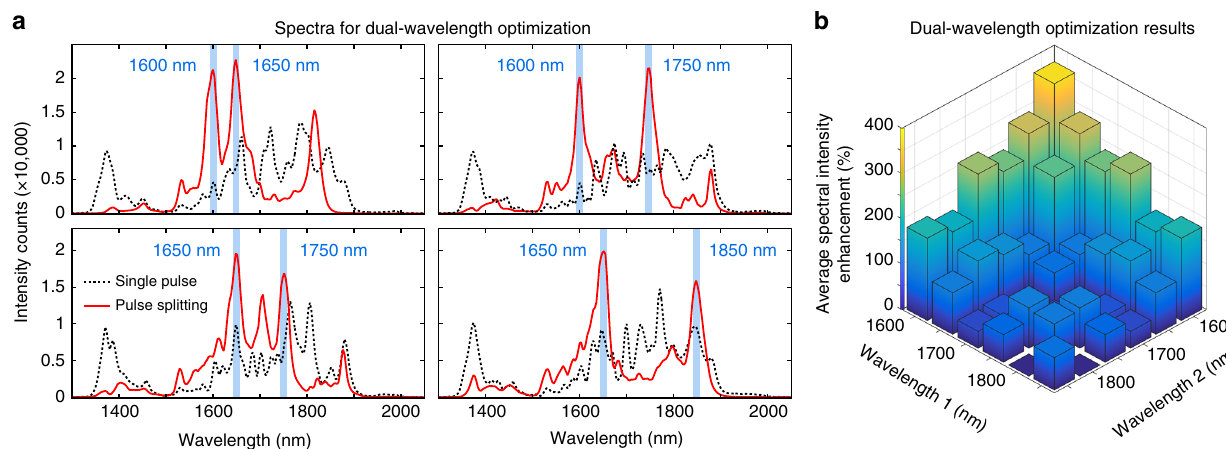
Fig. 4 Supercontinuum spectral intensity optimization for different wavelength pair combinations. a Examples of spectra obtained following simultaneous intensity maximization at two target wavelengths (blue shadings), using single pulse seeding (dashed black lines), or pulse-splitting optimizations (red lines — with up to 16 pulses). Note that we used here the same setup and power budget as in Fig. 3, and simply modi fi ed the algorithm optimization criteria (see Methods). b Optimization matrix for wavelength pair combinations, showing normalized intensity enhancement obtained for combinations of wavelength pairs. Such enhancement (see colour bar on the left axis) is calculated as the average intensity at both wavelengths and is normalized relatively to the single pulse seeding case (see Methods). For clarity, we only report results where the intensity at one wavelength is less than twice as large as the intensity at the other wavelength (see Supplementary Fig. 5, for a complete analysis)